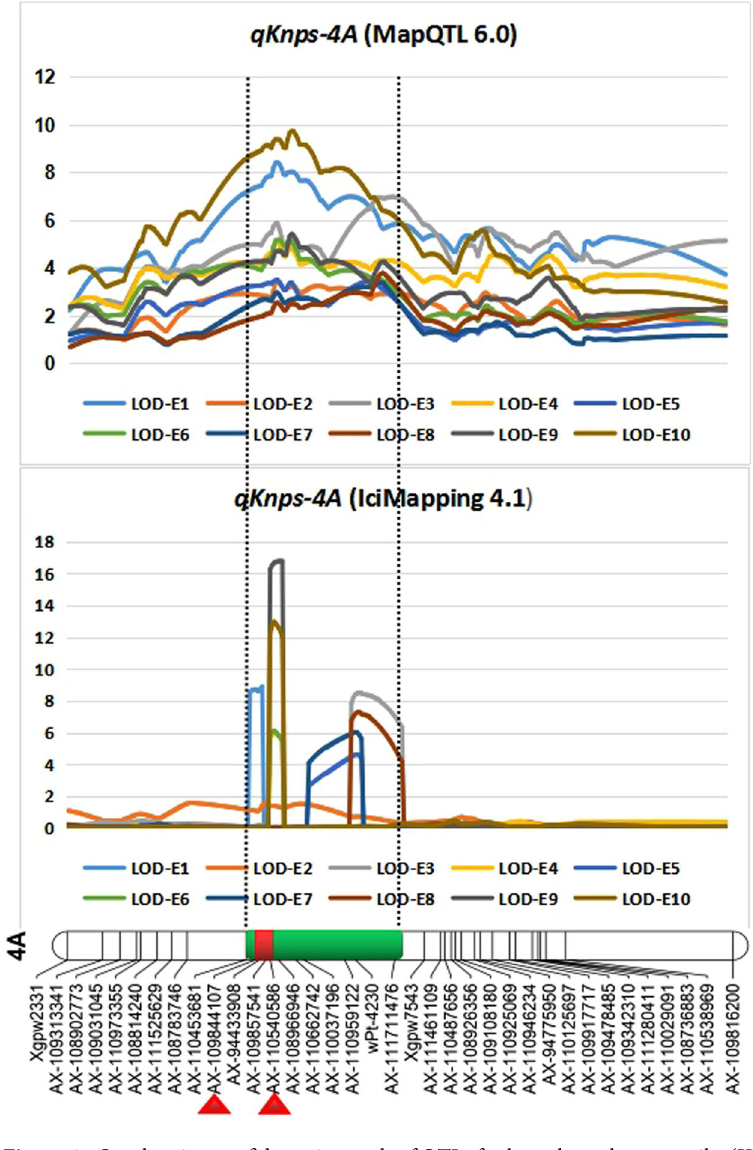
Figure 4. Overlapping confidence intervals of QTLs for kernel number per spike (KNPS) based on MapQTL 6.0, IciMapping 4.1 and QTLNetwork 2.0. The segments in red are the overlapping confidence intervals of qKnps-4A , and the overlapping flanking markers of qKnps-4A are indicated by triangles in red , which were detected by QTLNetwork 2.0 based on the combined 10 environmental phenotypic